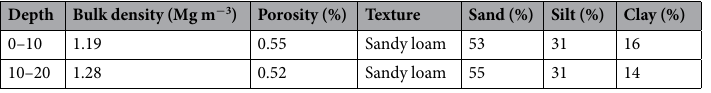
Table 2. Physical and textural characteristics of soil